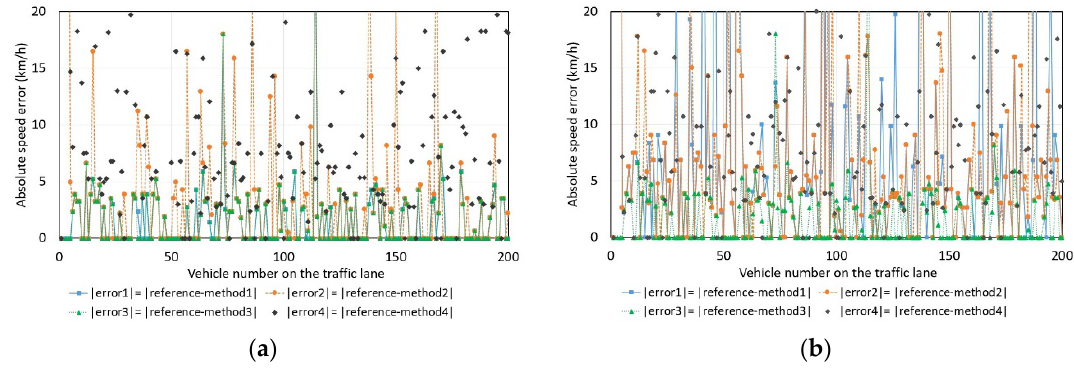
Figure 3. The absolute errors of the estimated speed values by means of methods 1, 2, 3, or 4 with reference to the radar speed readings: ( a ) The magnitude of magnetic field data was used for the calculations; ( b ) z -component of magnetic field data was used for the calculations.